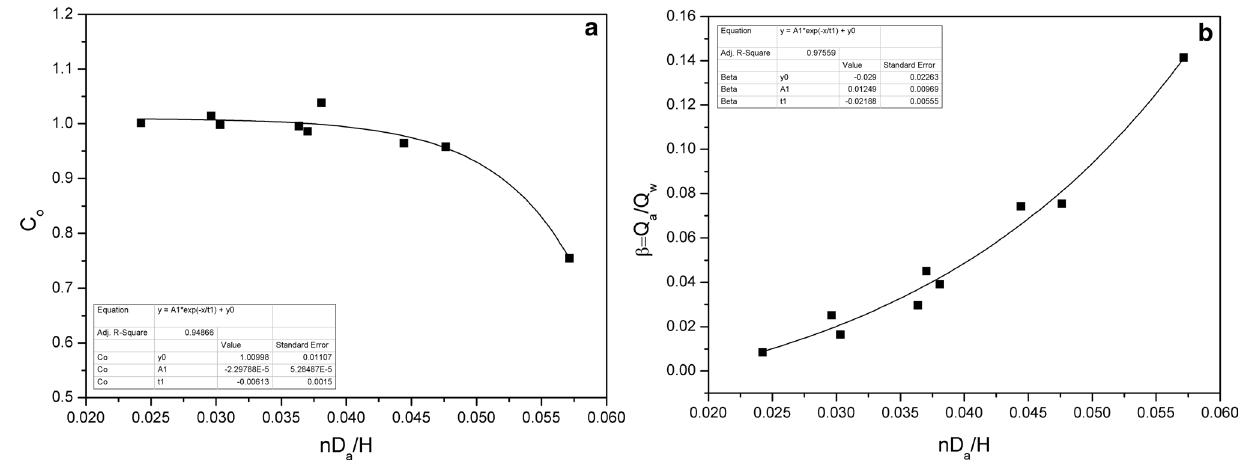
Fig. 9 Variations of discharge performance and air entrainment rates with relative aeration